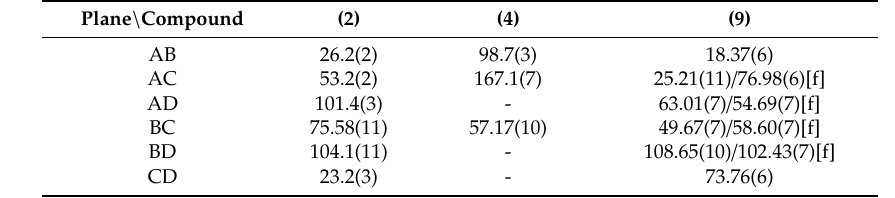
Scheme 5. Ring plane defined in compounds 2 , 4 , and 9 . Table 1. Torsion angles ( ◦ ) * of compounds 2 , 4 , and 9 .